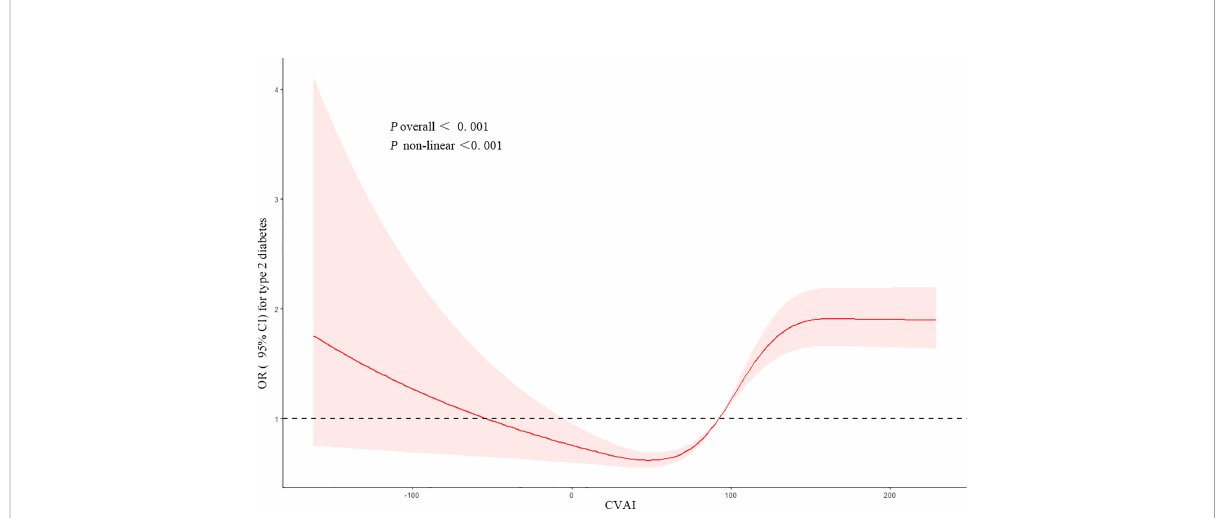
FIGURE 1 Restricted cubic spline of the association between CVAI and the risk of T2DM. The model was adjusted for age, gender, education level, location and marital status, smoking status, drinking status, sleep time, SBP, and DBP. The plot shows a non-linear (U-shaped) relationship between CVAI and the risk of T2DM. CVAI, Chinese visceral adiposity index; T2DM, type 2 diabetes mellitus; SBP, systolic blood pressure; DBP, diastolic blood